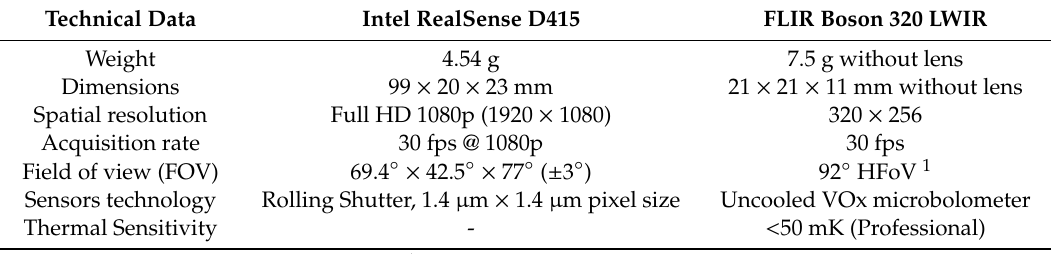
Table 2. Technical characteristics of the depth camera Intel RealSense D415 and FLIR Boson 320LW IR thermal camera.